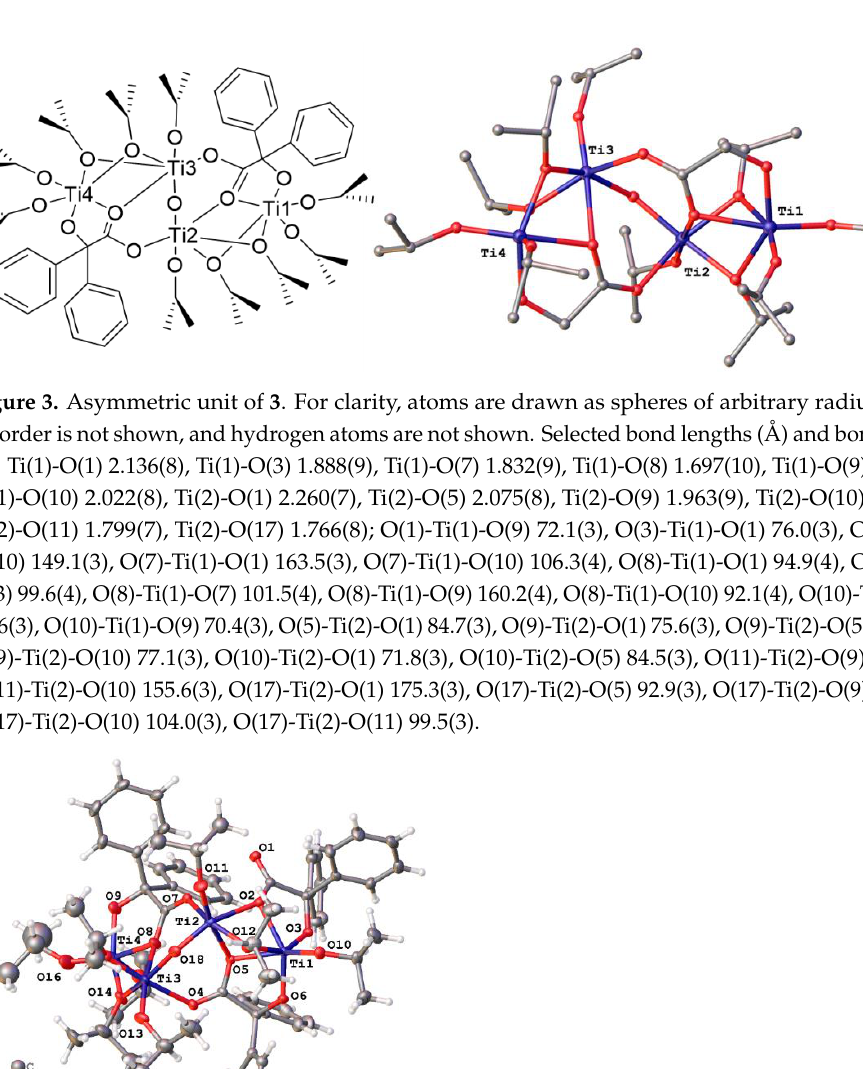
4 of 23 Figure 2. Asymmetric unit of 2 with atoms drawn as 50% probability ellipsoids. Dashed lines show classical hydrogen bonds. Selected bond lengths (Å ) and bond angles ( o ): Ti(1)-O(1) 2.0679(18), Ti(1)- O(3) 1.8377(18), Ti(1)-O(4) 2.0880 (19), Ti(1)-O(6) 1.8550 (19), Ti(1)-O(7) 2.097(2), Ti(1)-O(9) 1.8438(19); O(3)-Ti(1)-O(4) 161.49(8), O(3)-Ti(1)-O(6) 100.04(8), O(3)-Ti(1)-O(7) 96.16(8), O(3)-Ti(1)- O(9) 102.00(8), O(4)-Ti(1)-O(7) 84.34(8), O(6)-Ti(1)-O(1) 95.44(8), O(6)-Ti(1)-O(4) 77.91(8), O(6)-Ti(1)- O(7) 162.15(8), O(9)-Ti(1)-O(1) 158.84(8), O(9)-Ti(1)-O(4) 96.24(8), O(9)-Ti(1)-O(6) 105.17(9), O(9)- Ti(1)-O(7) 78.51(8). The coordination about Ti2 is similar (See the Supporting Information, Figure S3); two of the three benzilic acids are twice deprotonated, but the third is deprotonated only at the carboxylic acid. All are chelating in [1.011] mode. The alcohol does bind to Ti2, but also forms a hydrogen bond to an unbound molecule of acetonitrile. The X-ray scattering data were good enough that it was possible to identify the positions of the hydrogen at- oms through difference Fourier methods. In the case of [Ti(O i Pr) 4 ], varying the reaction stoichiometry led to the isolation of two different products. When using a ratio of 1:2 (L 1 H 2 :Ti), the product isolated was found to be [Ti 4 OL 12 (O i Pr) 10 ] ( 3 ). The clusters (Figure 3) in 3 contain four roughly octahedral Ti ions that are linked by benzilate, each of which has a [3.1 1 2 23 1 3 ] coordination mode, and by bridging isopropoxide; for an alternative view, see Supporting Information (Figure S4). The cluster can be described by dividing it into two similar halves. Benzilate is chelated to Ti1, but the carboxylate is also involved in bonding to Ti2 and Ti3. Ti1 and Ti2 are